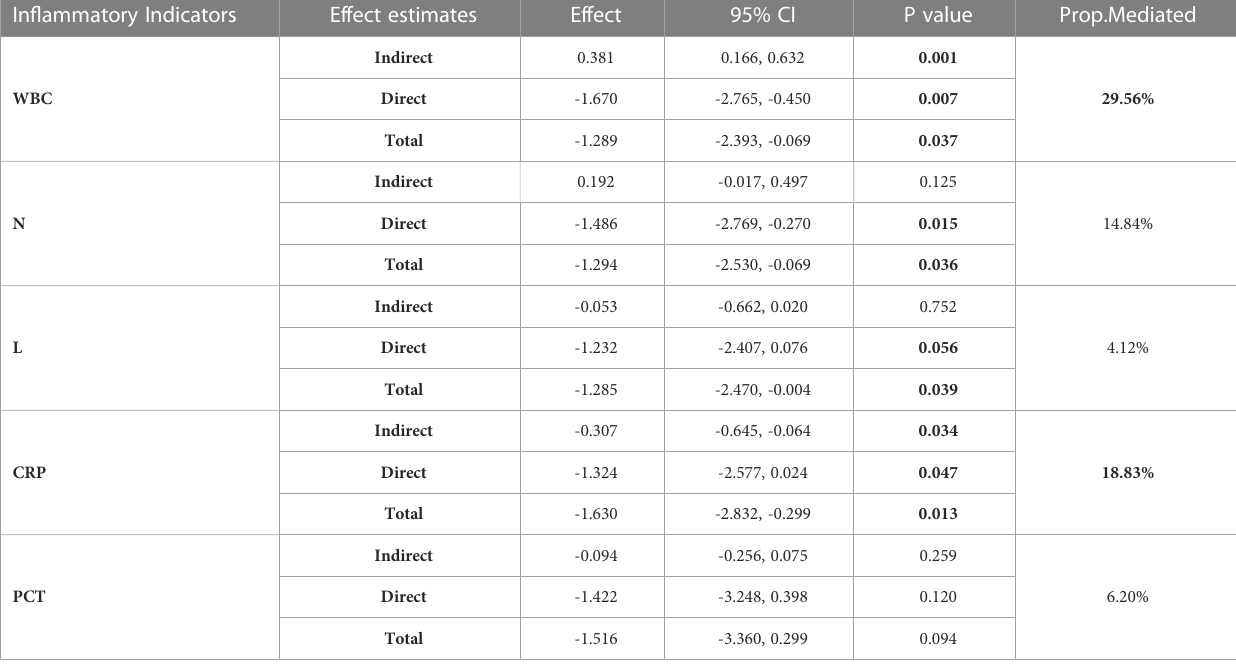
TABLE 4 Mediation effect estimates of in fl ammatory indicators on the association between the burden of comorbidity and Ct values. In fl ammatory